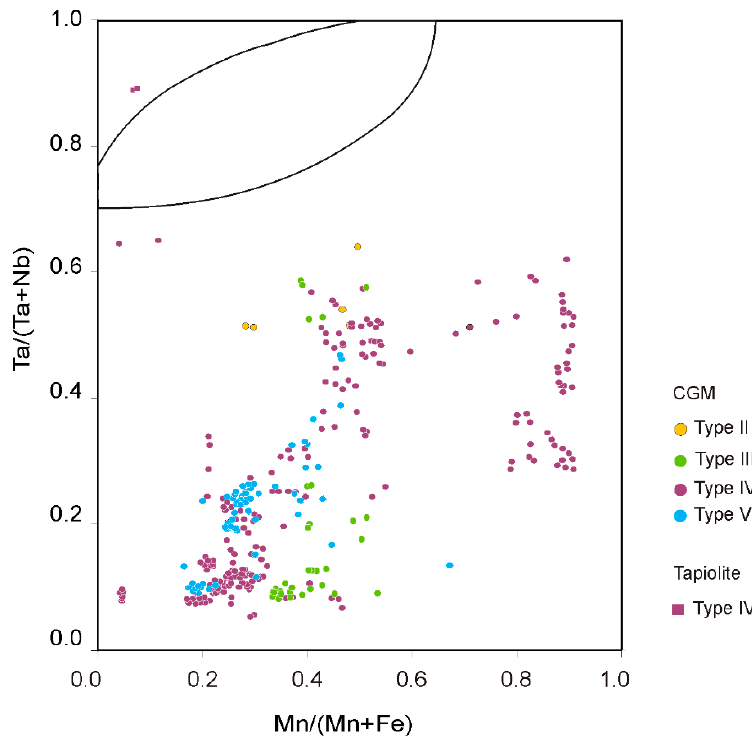
Figure 17. Composition of the CGM (dots) and tapiolite (square) from the Giraúl pegmatites in terms of the columbite quadrilateral (atomic ratios).